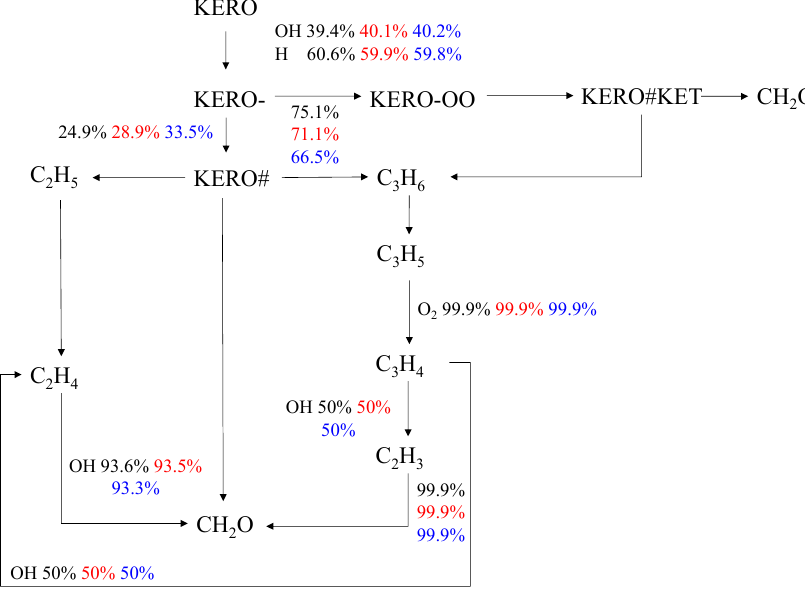
Figure 6. Effects of equivalence ratio on the chemical reaction path of kerosene (T = 800 K; P = 20 bar; black: Φ = 0.8; red: Φ = 1; blue: Φ = 1.2). Table 4. Lists of the important reactions of gasoline.